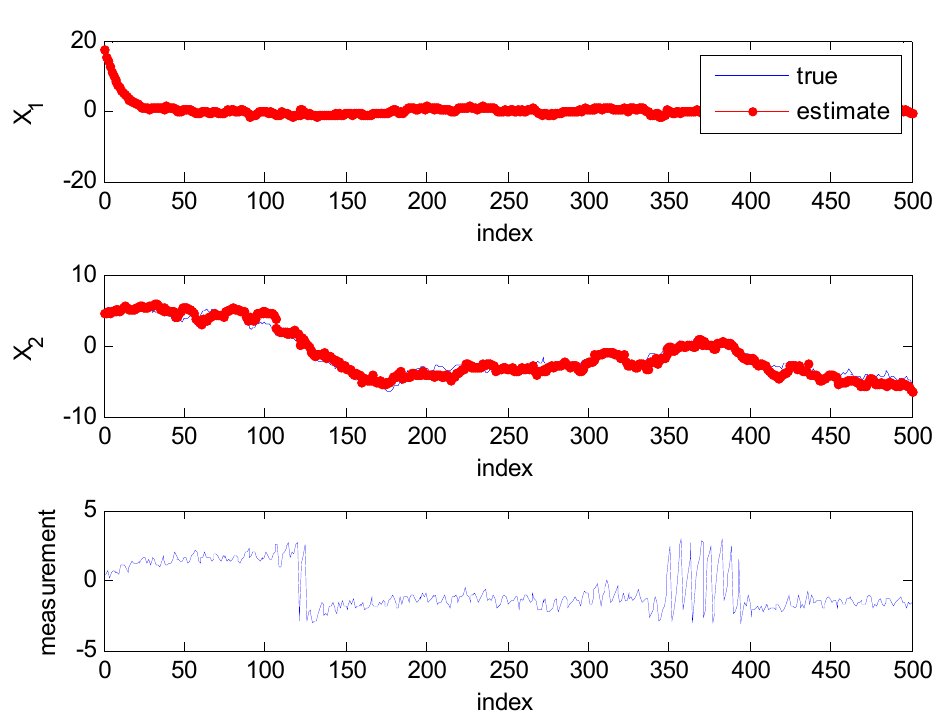
Figure 2. Estimate results measurement ( top : the first state estimate results, middle : the second state estimate results, bottom : the expected value of measurement).